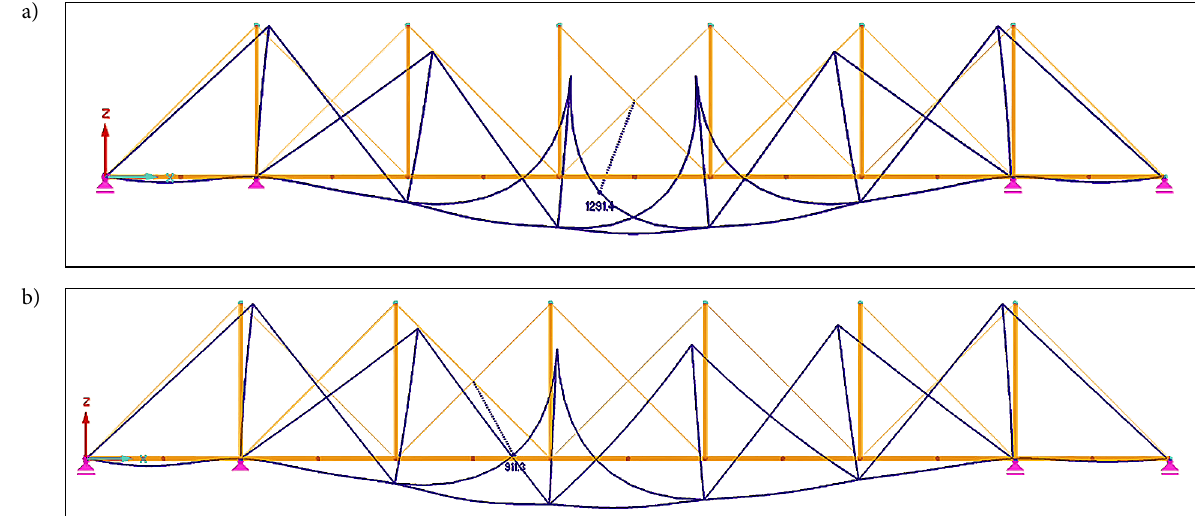
Figure 4. Equal pylons bridge. Deflections: a) under symmetrical loading; b) under